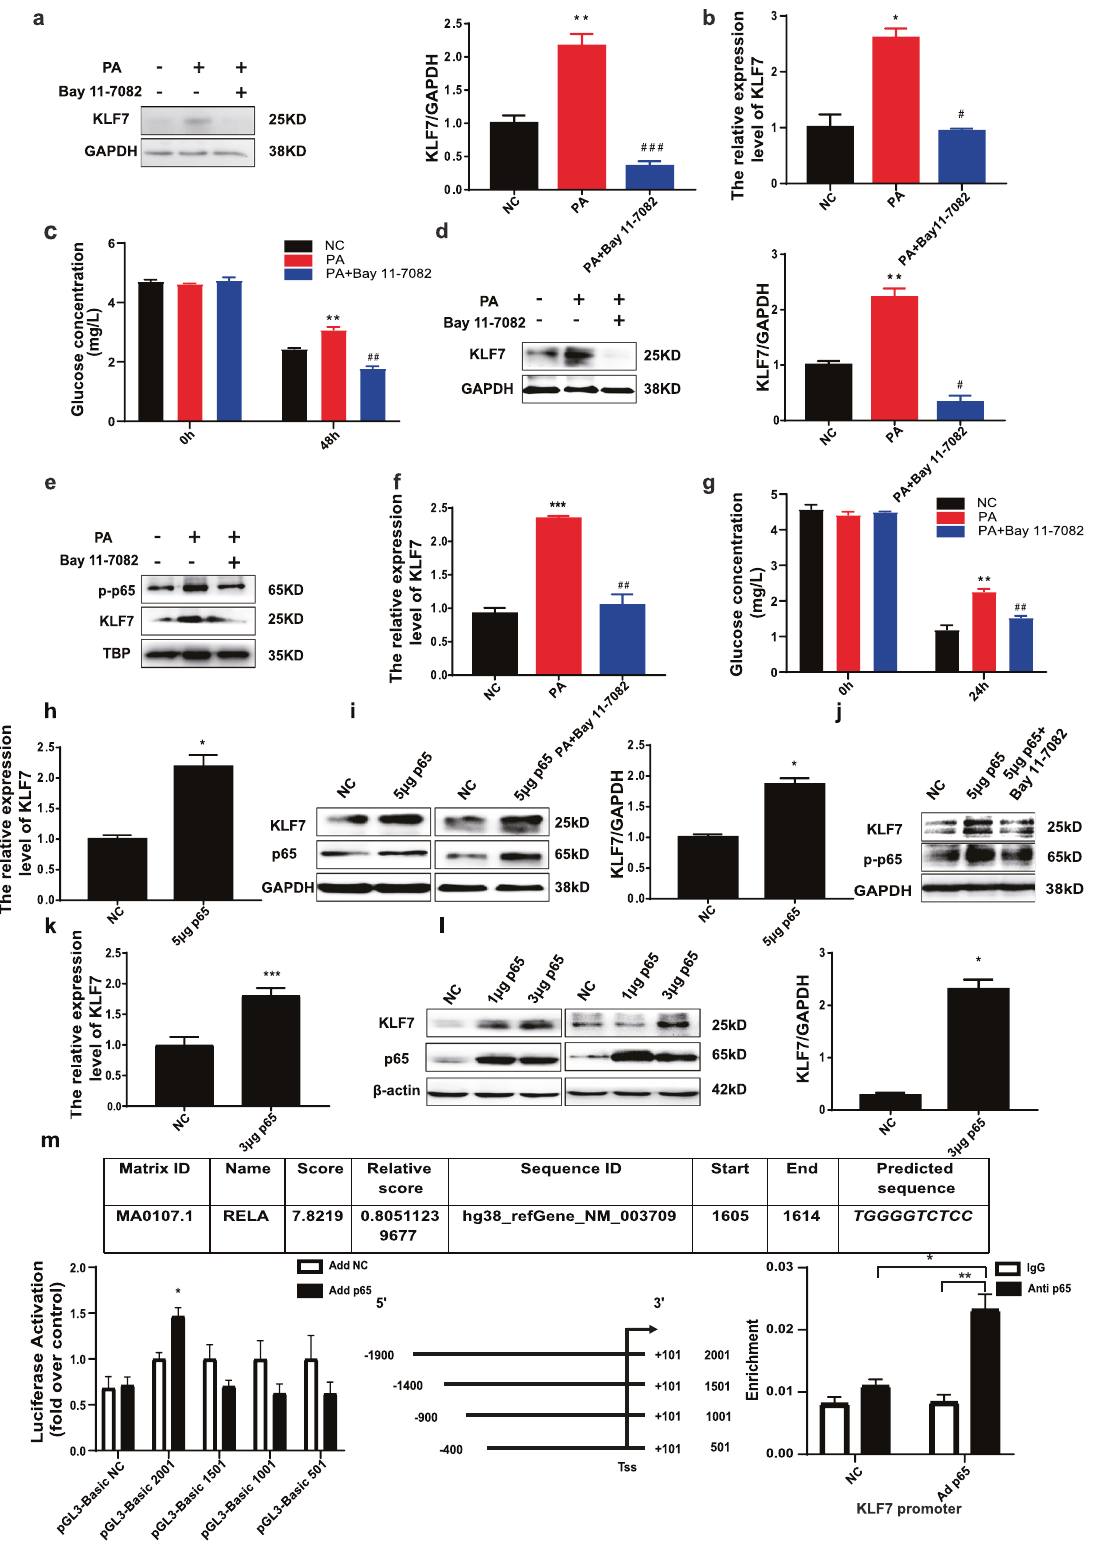
Western blot The separated proteins were electroblotted onto nitrocellulose fi lter membrane and blocked for 2 h at room temperature with Tris-buffered saline containing 5% BSA. Nitrocellulose fi lter membrane were